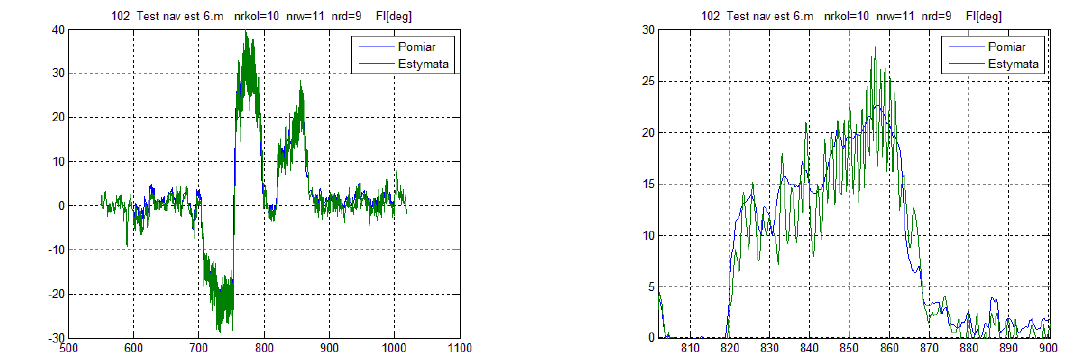
Figure 6. Roll angle [deg] estimation and enlarged fragment on the right – algoritm is described in sub-chapter